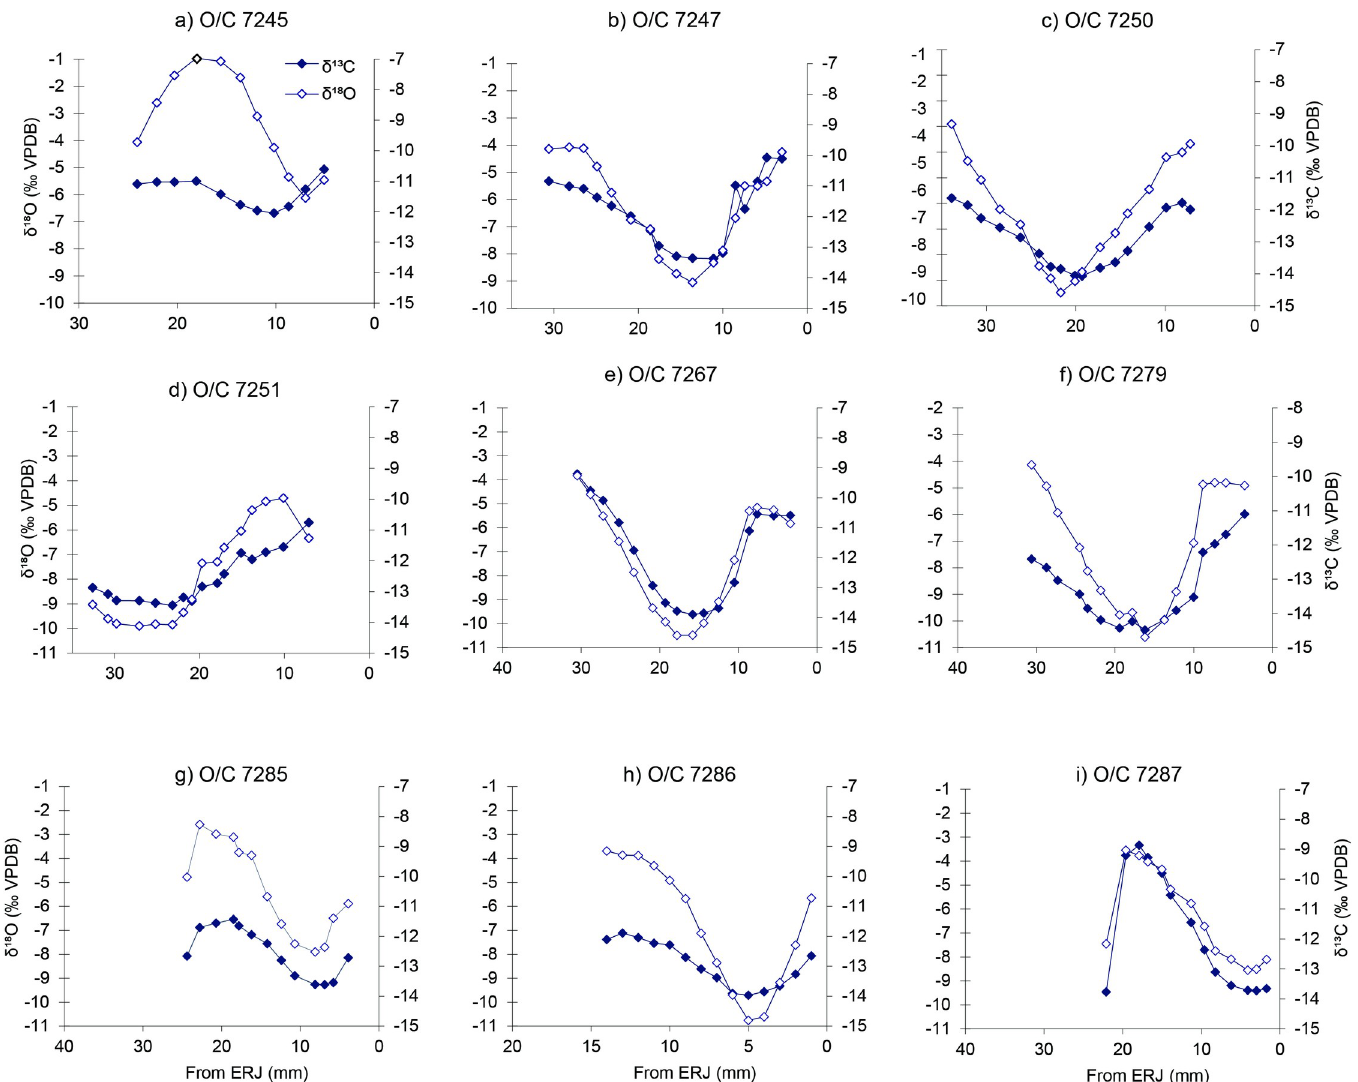
Fig 4. δ 13 C (filled diamond) and δ 18 O (open diamond) values for individual sheep/goat M3s, Vin č a-Belo brdo. Insets: a) O/C 7245, b) O/C 7247, c) O/C 7250, d) O/C 7251, and Stubline e) O/C 7267, f) O/C 7279, g) O/C 7285, h) O/C 7286 and i) O/C 7287. ERJ is the enamel root junction.